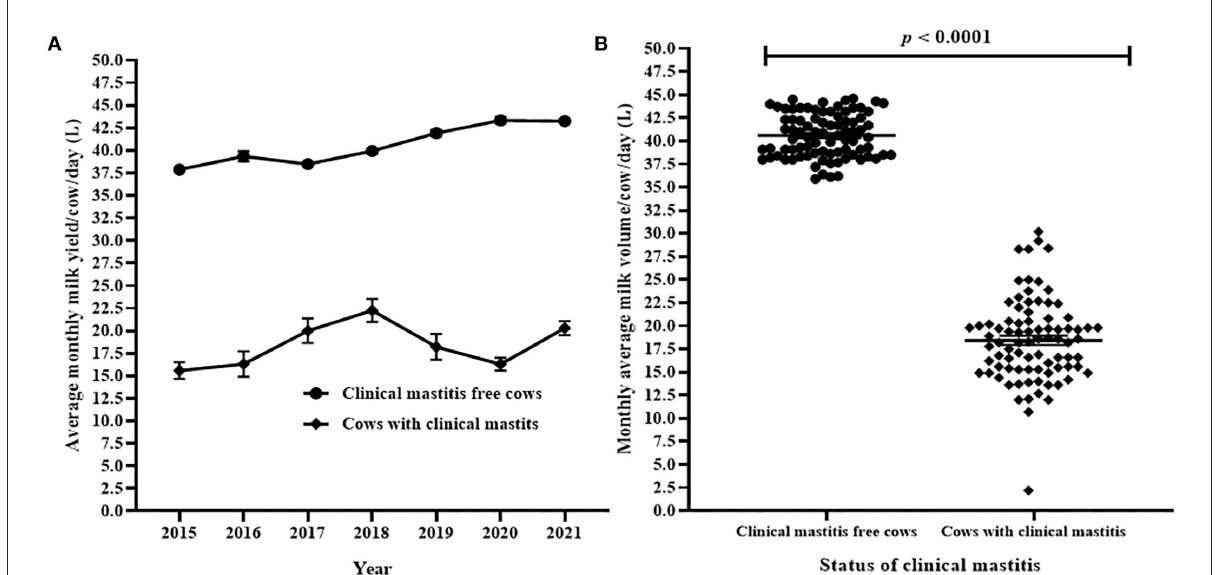
FIGURE6 Comparison of average monthly daily milk yield per cows with clinical mastitis and cows free from clinical mastitis. (A) The difference of annual average monthly daily milk yield between cows affected by clinical mastitis and cows free from clinical mastitis. In (B) , each solid circle and solid square represent the observed average monthly daily milk yield of cows with clinical mastitis and cows free from clinical mastitis, respectively. The recorded difference in the observed average monthly daily milk yield between the groups of cows was significant (Welch’s correction t = 39.68, p <